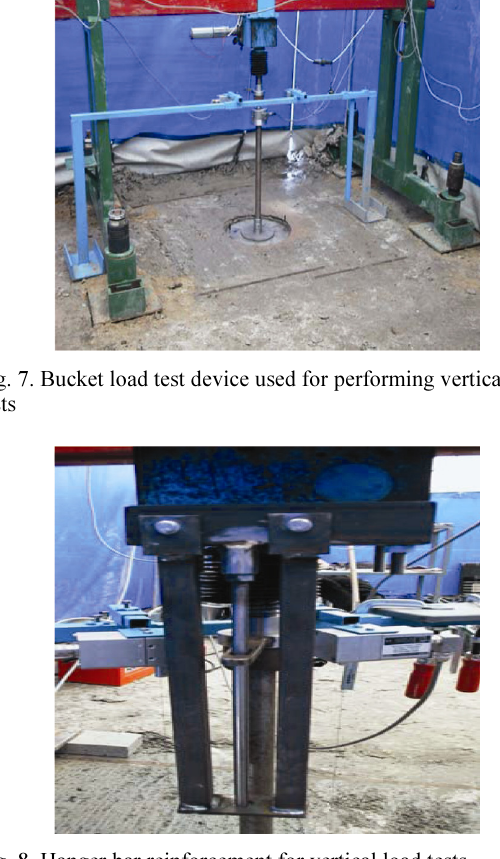
Fig. 8. Hanger bar reinforcement for vertical load tests